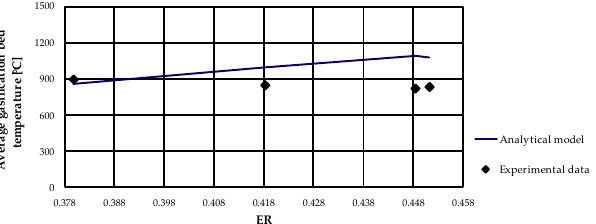
Figure 3. Comparison of average gasification bed temperature between analytical model results and experimental data from hazelnut shell [66].